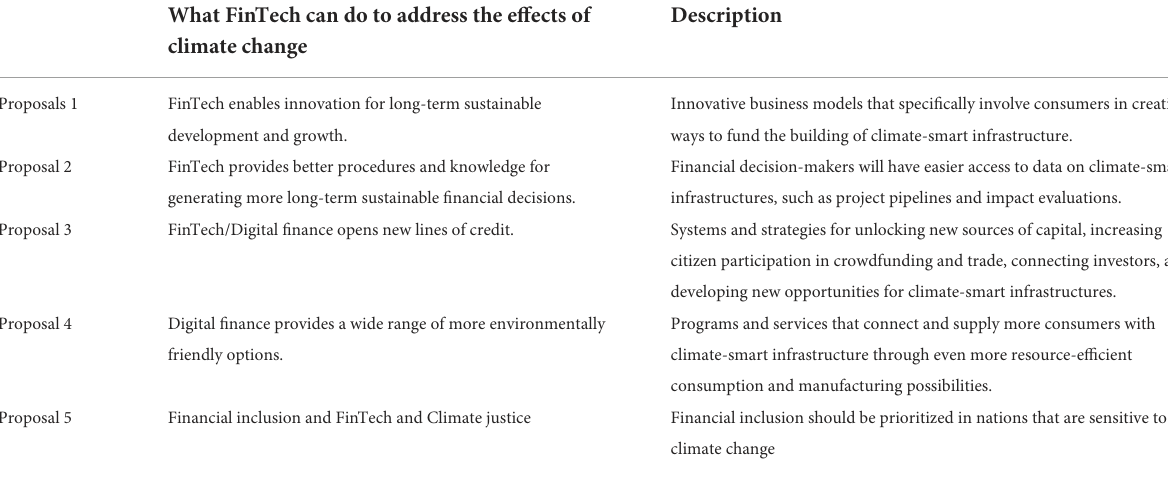
TABLE 2 How FinTech allows citizens to support climate-smart